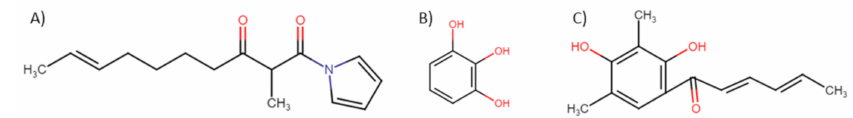
Figure 4. Chemical structure of the secondary metabolites identified in the PO212 crude extract